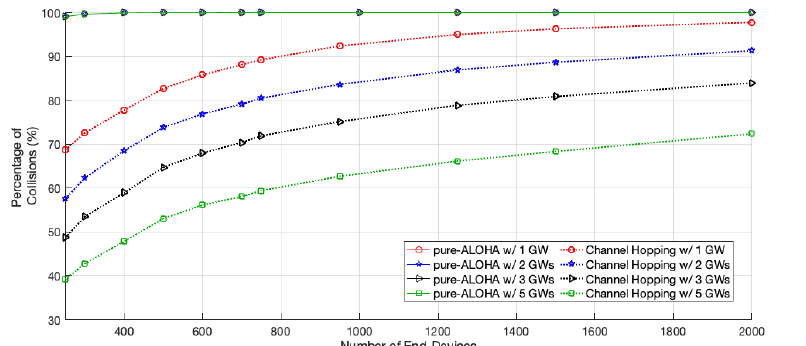
Figure 6. Percentage of collisions.